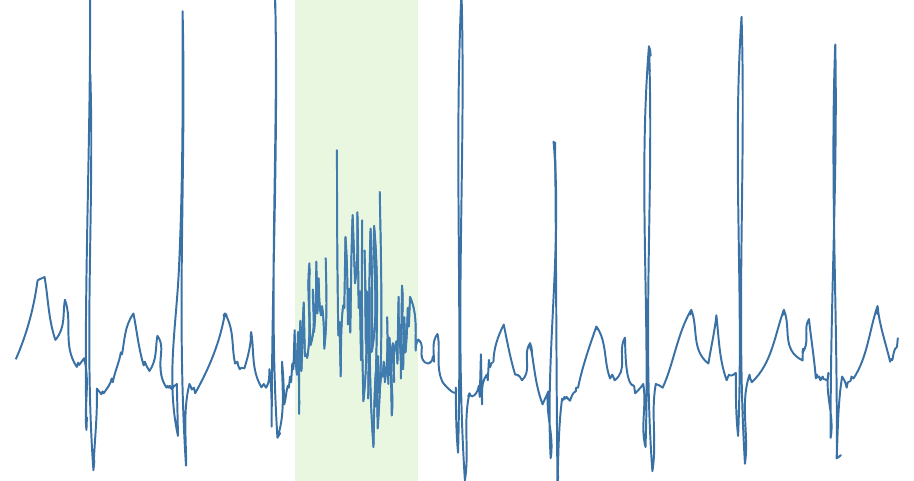
Figure 1. An example of an ECG trace with artifacts (colored band). An R wave cannot be detected due to